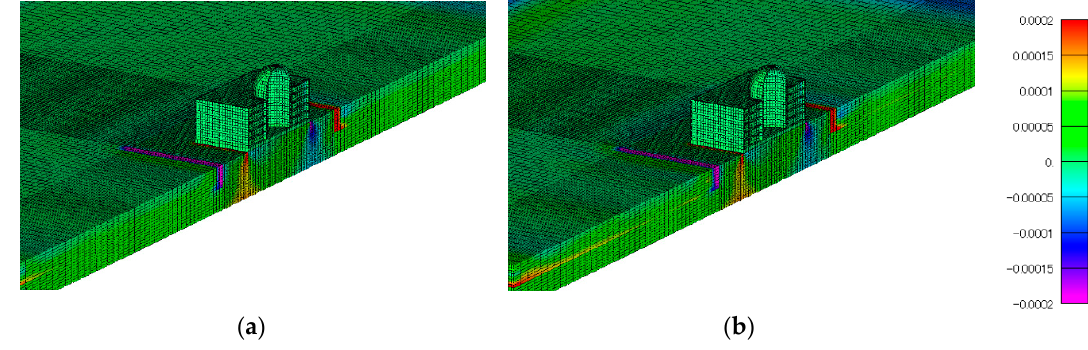
Figure 12. Shear stress–shear strain relations: ( a ) the response in YZ direction in upper layer of sand, ( b ) the response in ZX direction in upper layer of sand, ( c ) the response in YZ direction in lower layer of sand, and ( d ) the response in ZX direction in lower layer of sand. Blue line is the response of the original model and red line is that of the proposed model.